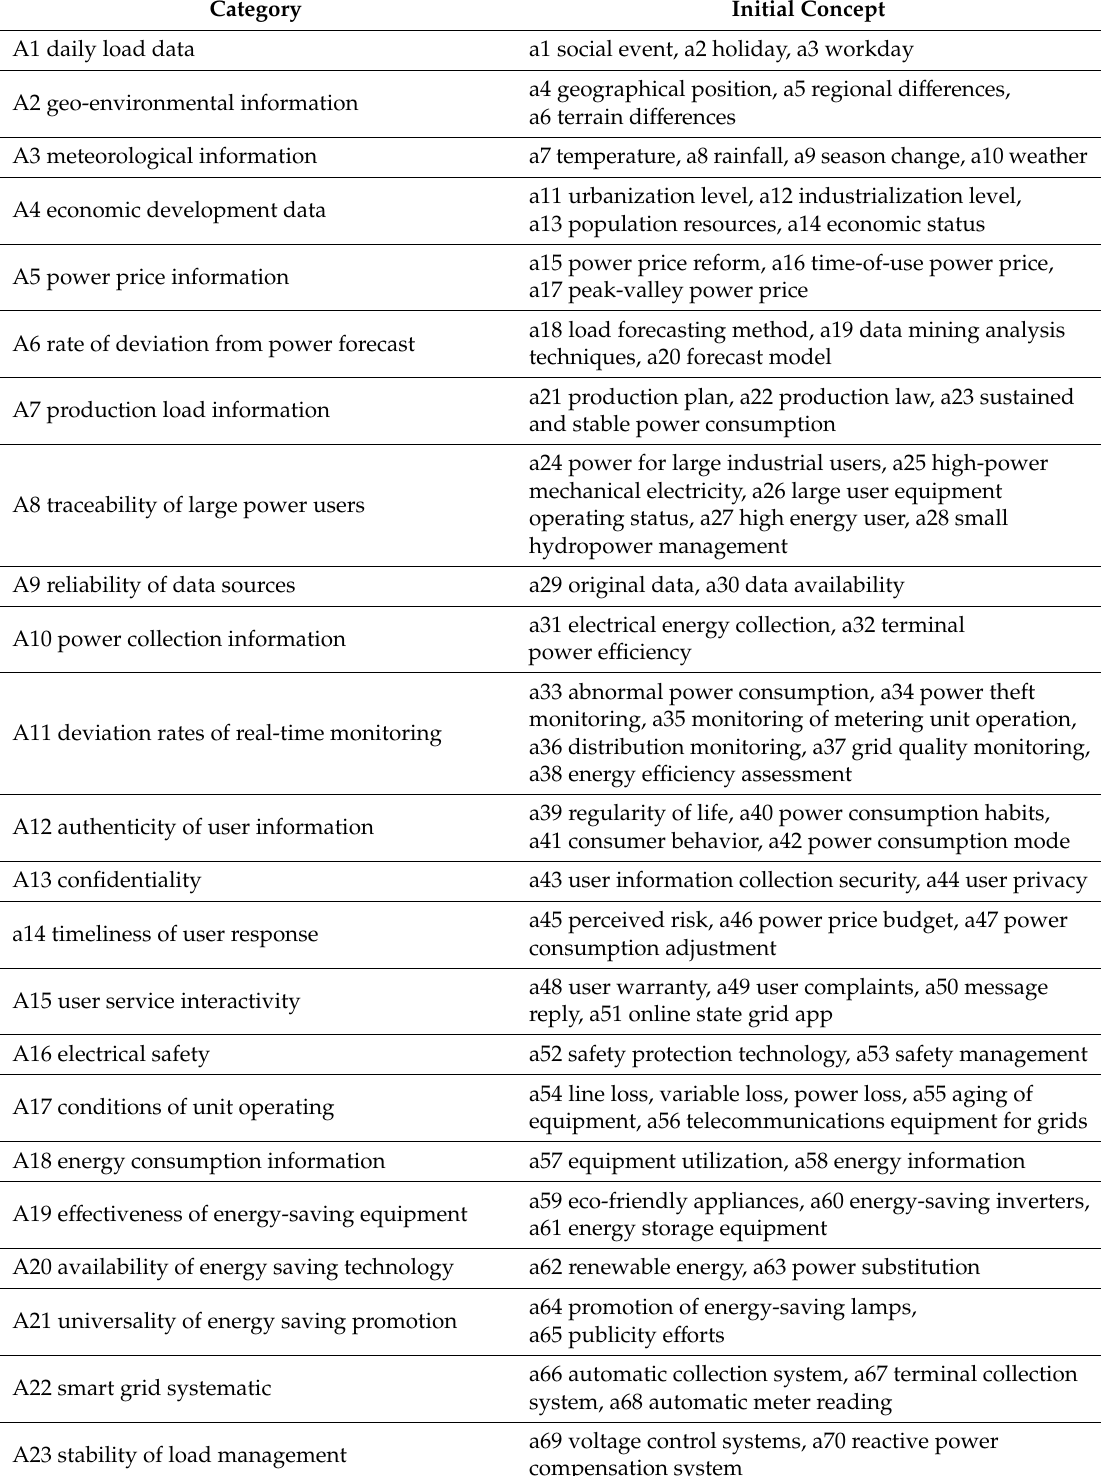
Table 1. Results of open